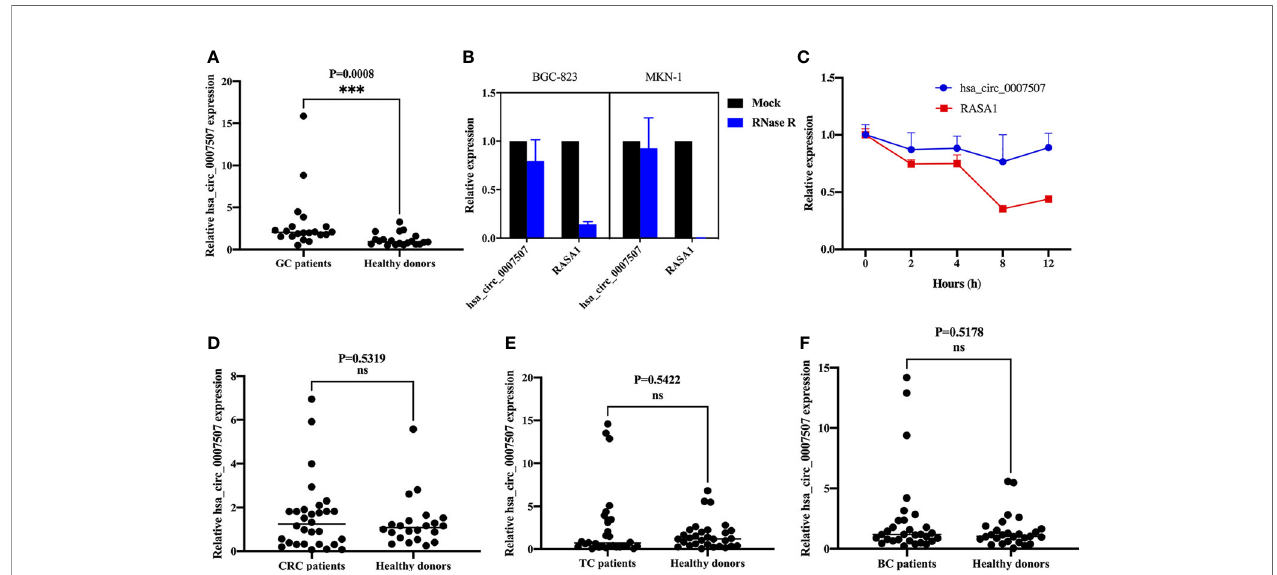
FIGURE 2 | The characteristics of hsa_circ_0007507. (A) Differential expression of hsa_circ_0007507 in the serum of GC patients (n=20), and healthy donors (n=20). (B) Stability of hsa_circ_0007507 con fi rmed by Rnase R digestion assay. (C) Longer half-life of hsa_circ_0007507 veri fi ed by actinomycin D assay. (D) Differential expression of hsa_circ_0007507 in the serum of colorectal cancer patients (n=30), and healthy donors (n=22). (E) Differential expression of hsa_circ_0007507 in the serum of thyroid cancer patients (n=30), and healthy donors. (n=30). (F) Differential expression of hsa_circ_0007507 in the serum of breast cancer patients (n=30), and healthy donors. (n=27). Indicated statistical signi fi cance (*** p < 0.001), ns indicated p >